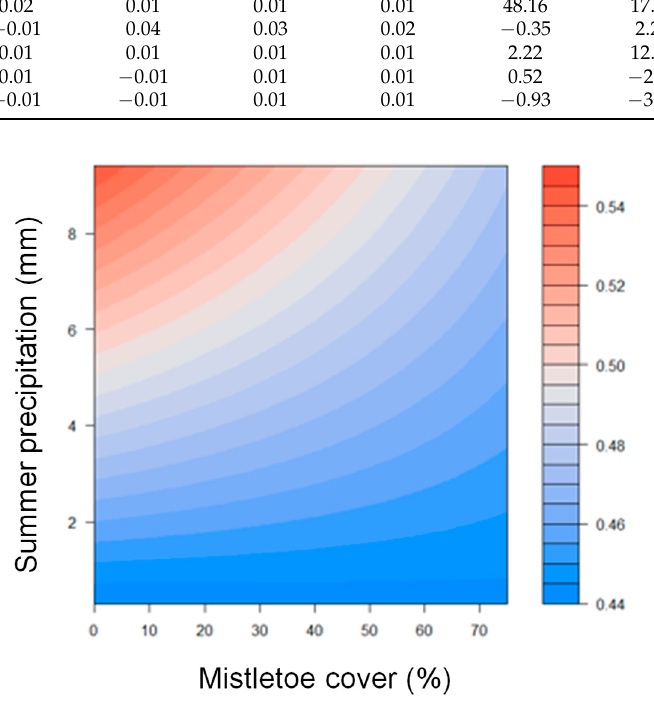
Table 2. Summary of the main statistics characterizing the selected linear mixed-effects models fitted to juniper growth (basal area increment) as a function of year, mistletoe infestation, summer precipitation and interactions. Variable Mistletoe infestation